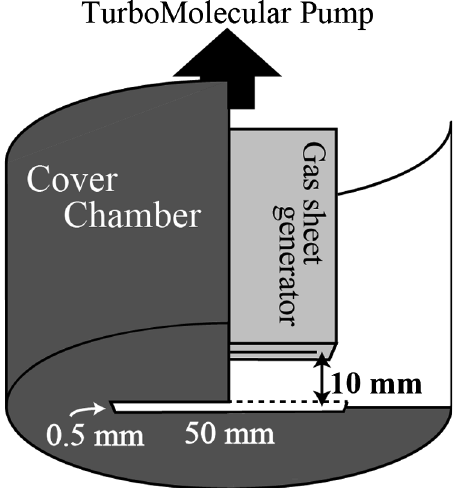
FIG. 9. The gas pressures at the main chamber, the pressure at the RFQ, the gas flux forming the gas sheet, and the introduced gas flux to the generator against the inlet gas